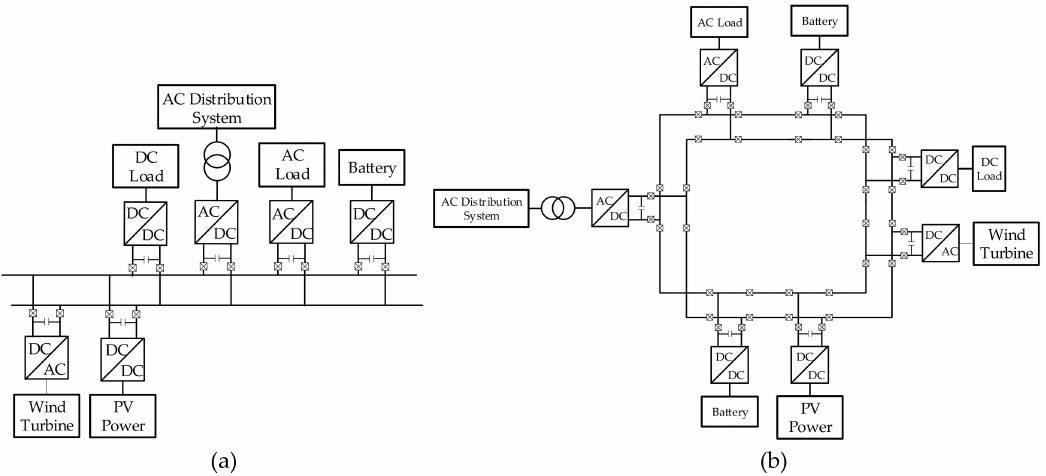
Figure 2. Two kinds of conventional DC microgrids. ( a ) The structure of a single-bus DC microgrid; ( b ) the structure of a ring-bus DC